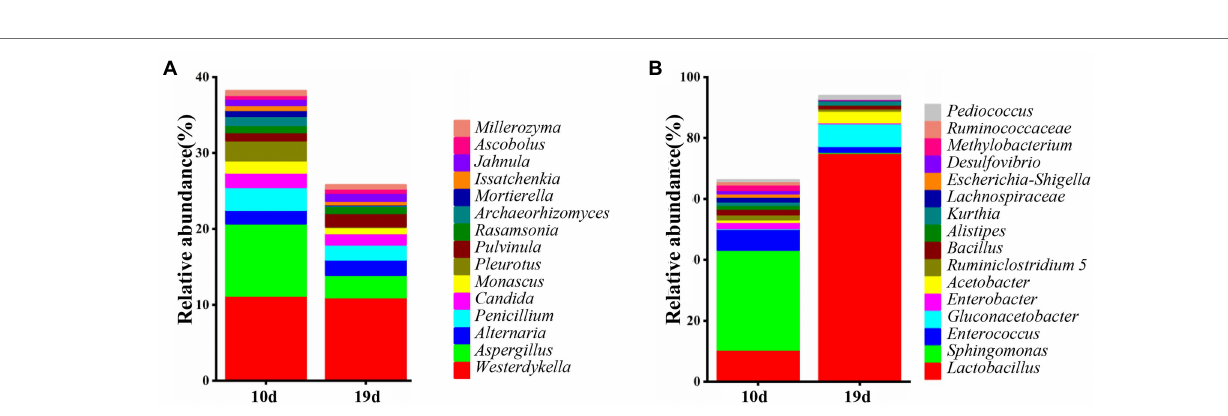
FIGURE 3 | Chemical composition dynamic changes of LZF after fermentation. (A) Content of iridoids (Genipin-1- β -D-gentiobioside, Geniposide, and Genipin) during fermentation of LZF; (B) Content of alkaloids during fermentation of LZF.